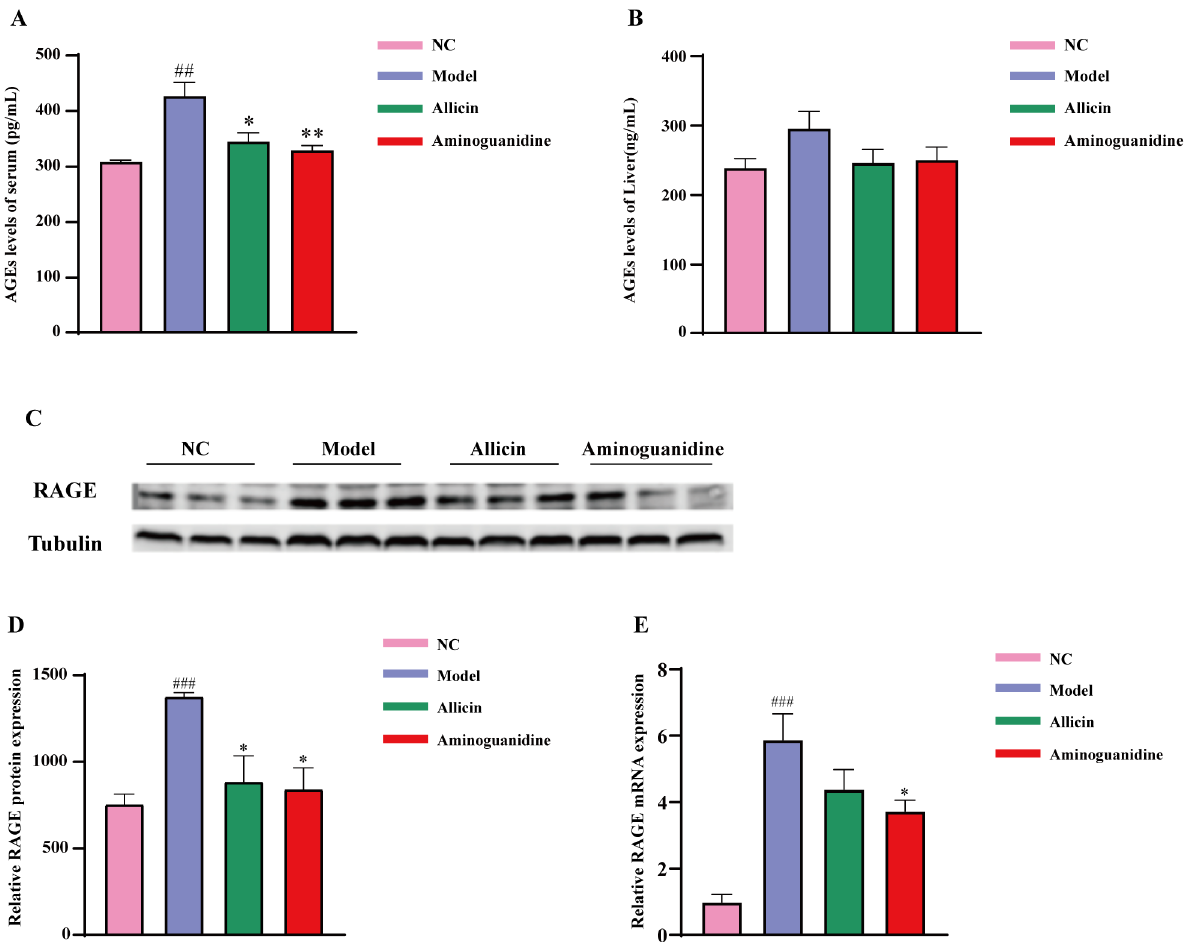
Figure 3. Effects of allicin on AGE levels and RAGE in the serum and liver of diabetic rats. The drugs were administered at the end of the 7th week of the experiment, with a 6-week dosing cycle. The experiment ended at the 13th week, and the rats were sacrificed at the same time. ( A ) AGE levels in serum, ( B ) AGE levels in liver, ( C , D ) relative protein expression of RAGE, and ( E ) mRNA expression of RAGE. “#” Significant difference between the model group and NC group. “*” Significant difference between the model group and medicine group. ( ### p < 0.001, ## p < 0.01, ** p < 0.01, and * p < 0.05). The horizontal axes in ( A , B , D , E ) represent the NC, Model, Allicin and Aminoguanidine group respectively from left to right.